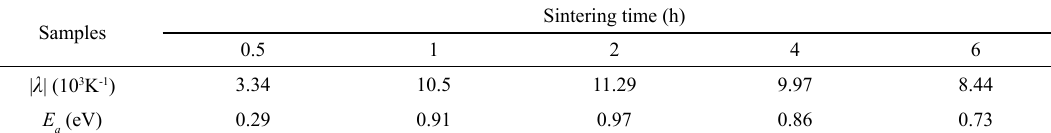
Table 1. Activation energy of the BTN samples, sintered at 1190 °C for different times and reoxidized at 800°C for 1 h.